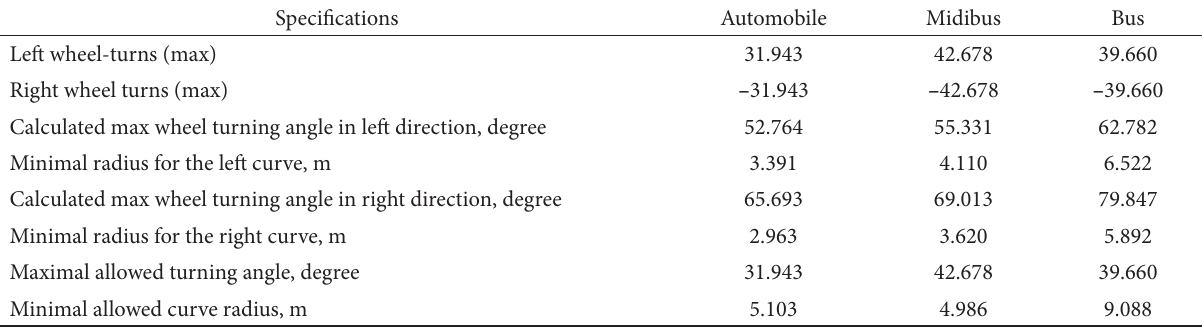
Table 6. Driving analysis report results showing wheel turning angles used by vehicles on the road and minimum/maximum curve